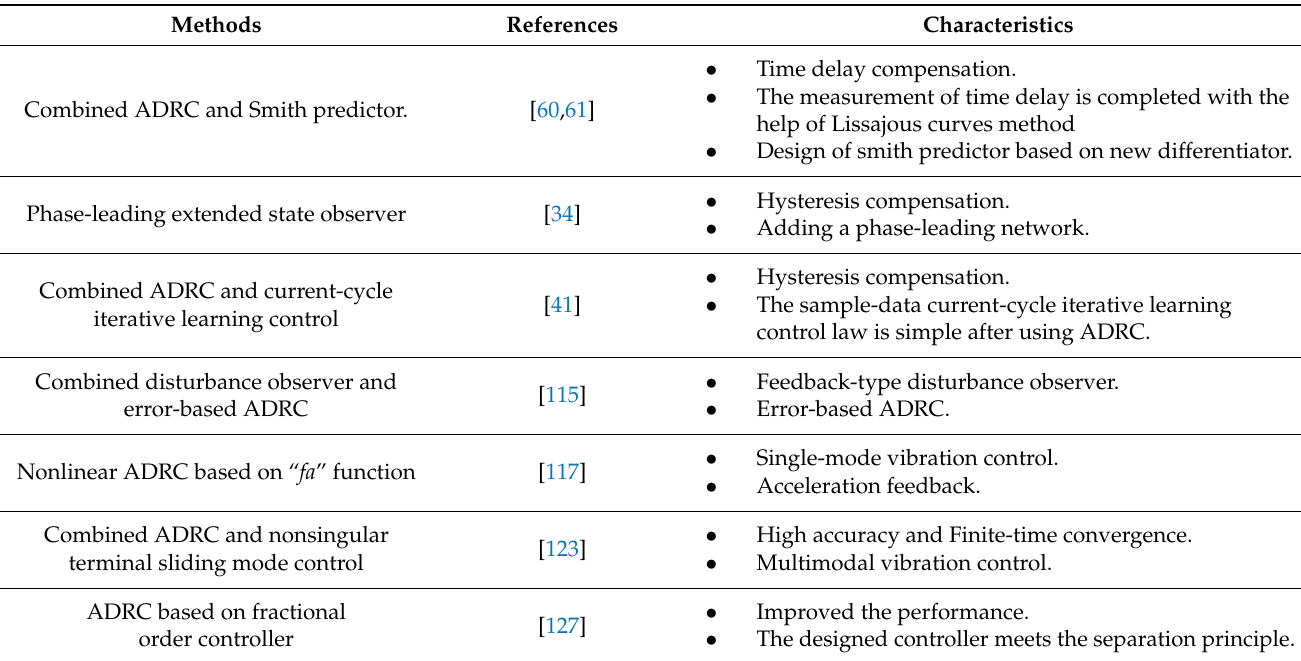
Table 3. Methods comparison